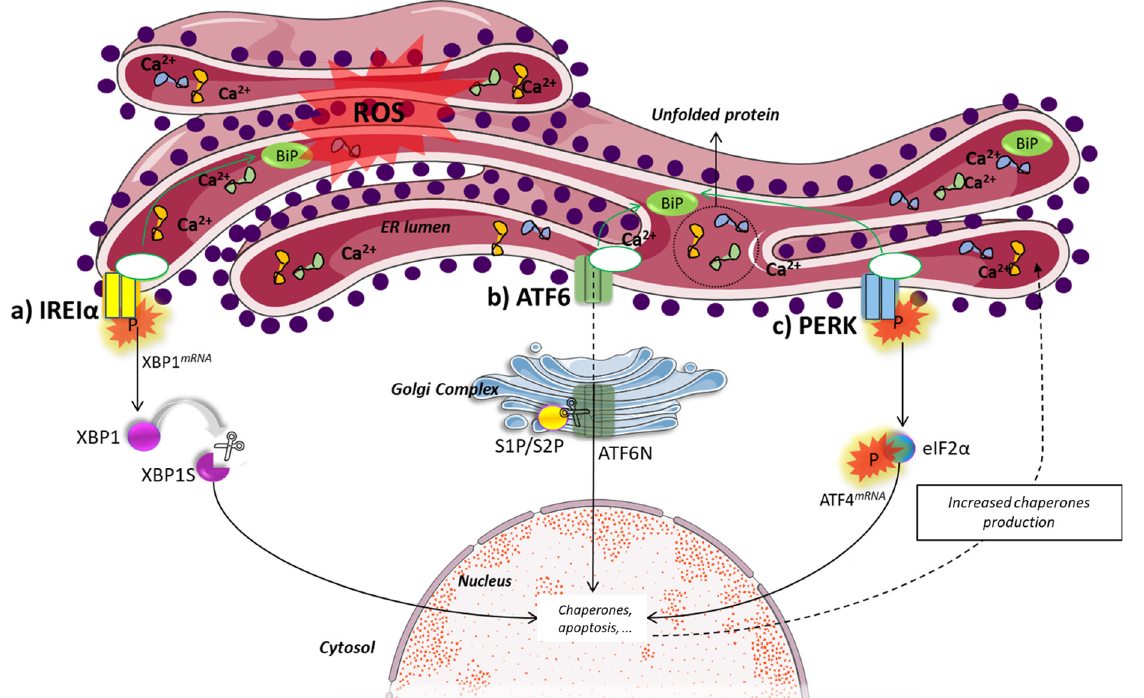
Figure 2. Activation of responses to protein malformation. These three pathways—IRE1 α ( a ), ATF6 ( b ) and PERK ( c )—are activated in unfolded protein response (UPR) to cope with disturbances in protein folding and to restore endoplasmic reticulum homeostasis after stress. The phosphorylation of eIF2 α is a hallmark of immunogenic cell death. Legend: ROS: reactive oxygen species; BiP: Binding immunoglobulin protein; ER: endoplasmic reticulum; IRE1 α : inositol-requiring enzyme 1 α ; XBP1: X box-binding protein 1 mRNA; XBP1S: spliced X box-binding protein 1 mRNA;